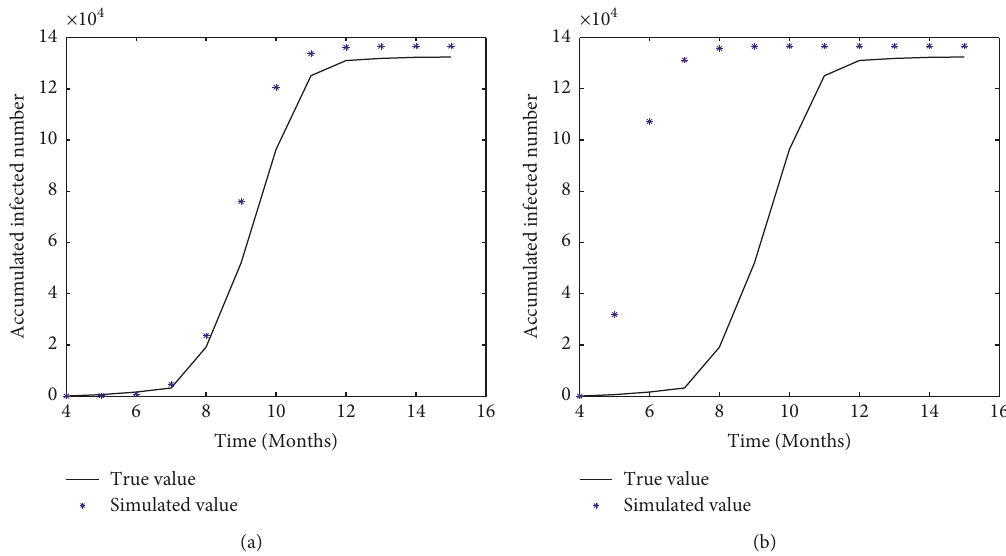
Figure 9: Fitting effect of simulated data and observed data of ABC-SMC algorithm. (a) Logistic model. (b) Gompertz model. Here, the � 22 , T � 6 , t � 12 , ε � 168655 , 106154 , 78152 , 64957 , 59245 , and 41355 , and p ( M 1 ) � p ( M 2 ) � 1/2. initial states are n � 6000 ,x 0